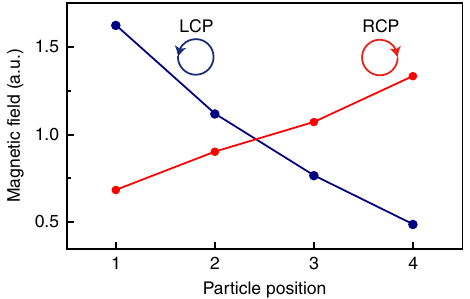
Fig. 6 Measured magnetic fi eld magnitude in the case of higher-order exceptional point. Four spheres with equal separations of d = λ plas were placed on the dielectric waveguide shown in Fig. 5a. The system is excited by a microwave of left-handed circular polarisation (LCP) or right-handed circular polarisation (RCP). The results show a monotonic trend that agrees with the model results in Fig.